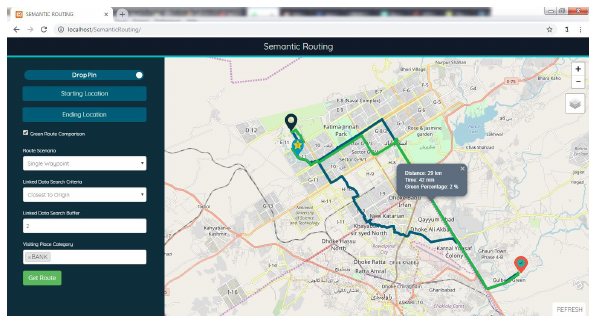
Figure 13. Green route comparison